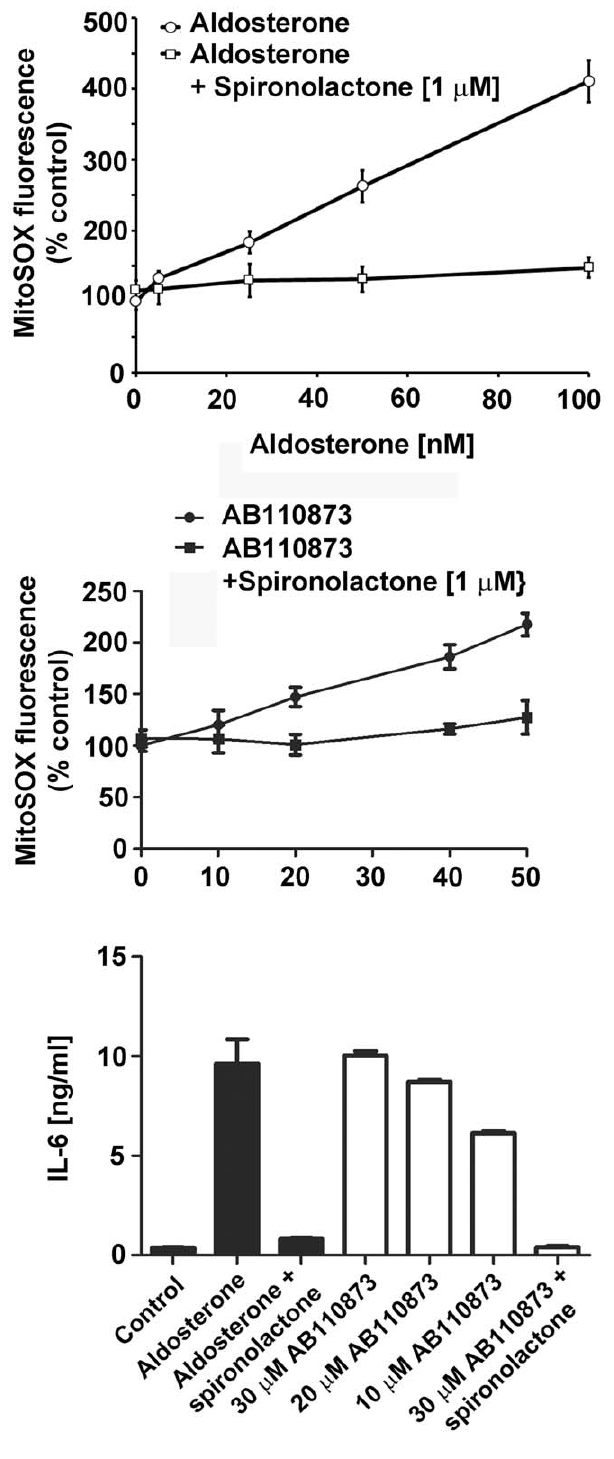
Figure 6. Increased mitochondrial superoxide generation and induction of IL-6 production upon MR activation in BV2 cells. BV2 microglial cells were incubated for 24 h with increasing concentra- tions of aldosterone ( A ) or silane AB110873 ( B ) in the presence or absence of 1 m M spironolactone, followed by determination of mitochondrial superoxide using MitoSox staining as described in the Methods section. Fluorescence was analyzed using a Cellomics ArrayScan high-content screening system. C , BV2 cells were incubated for 24 h with aldosterone (5 nM) or various concentrations of silane AB110873 in the presence or absence of spironolactone, followed